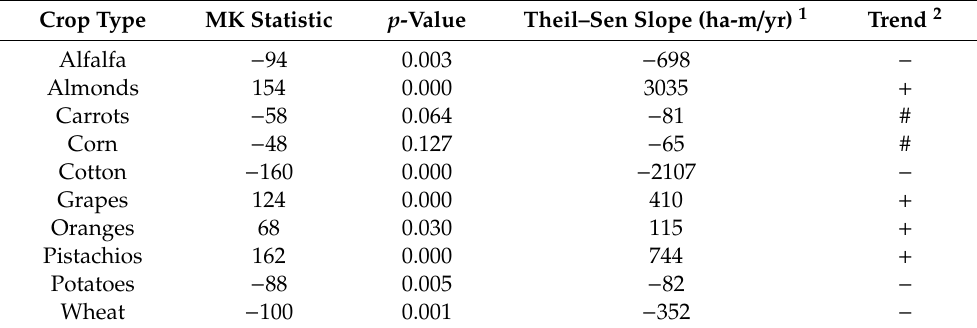
Table 9. Simple Mann–Kendall trend results for crop water use by volume of 10 major commodities in Kern County from 1999 to 2018 showing: (1) Mann–Kendall trend statistic, (2) p -value, (3) Theil–Sen slope (in hectare-meters) from 1999 to 2018, and (4) the significant trend where ( + ) and ( − ) indicate statistically significant increasing or decreasing, respectively, trends where the p -value is less than 0.05 and (#) signifies the trend is not statistically significant and the p -value is greater than